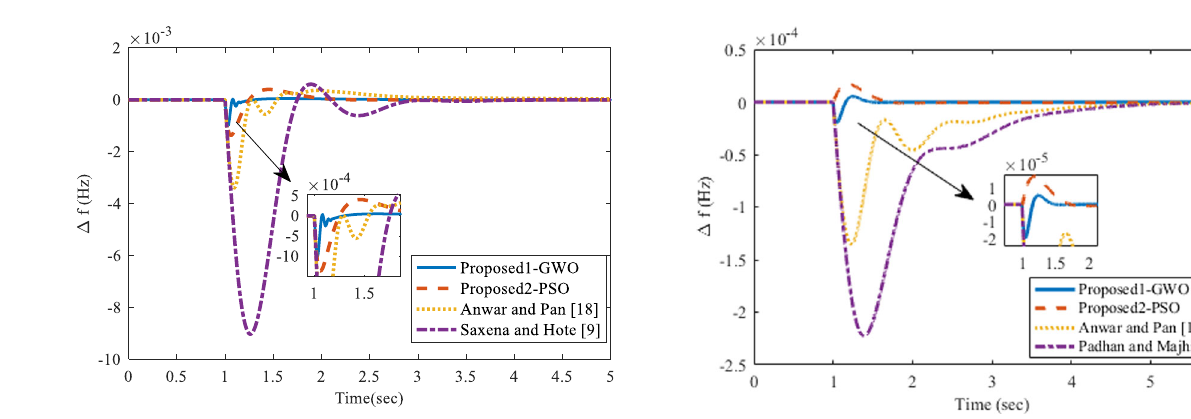
Fig. 5 Frequency regulation for case study 2